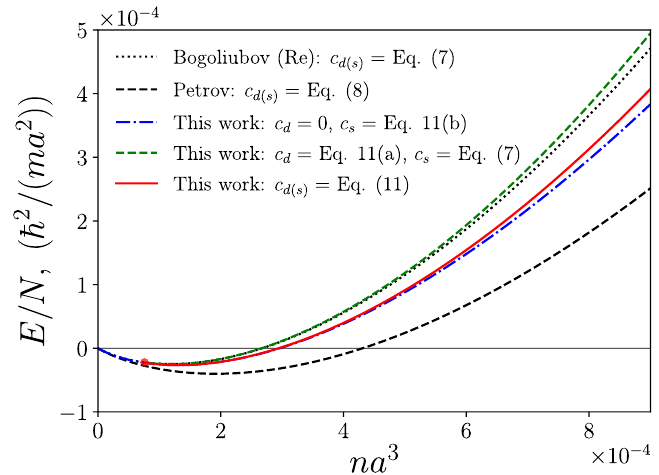
Figure 2: Energy per particle as a function of density for δ g / g = − 0.2. The black dotted line is the real part of the LHY result Eq. (3) with the Bogoliubov sound (7), / g = − 1 in the LHY term as while the black dashed line is obtained by setting g 12 it was originally done in Ref. [ 3 ] . The green dashed and blue dotted-dashed lines correspond, respectively, to the inclusion of higher order term in the density (11a) and spin (11b) sound velocity. The red solid line includes both density and spin corrections. The circle indicates the spinodal